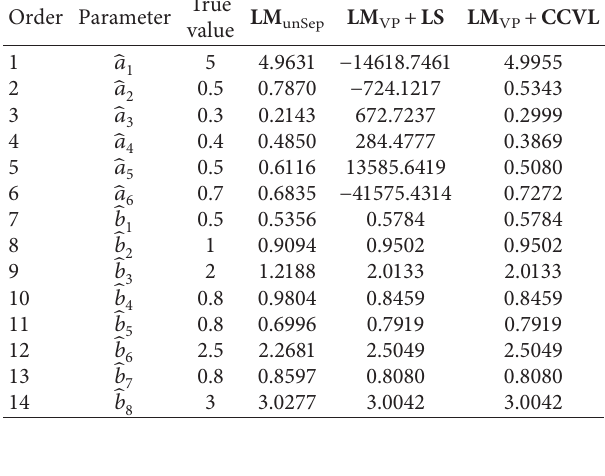
Table 4: Parameters estimation and true values for Example 2.